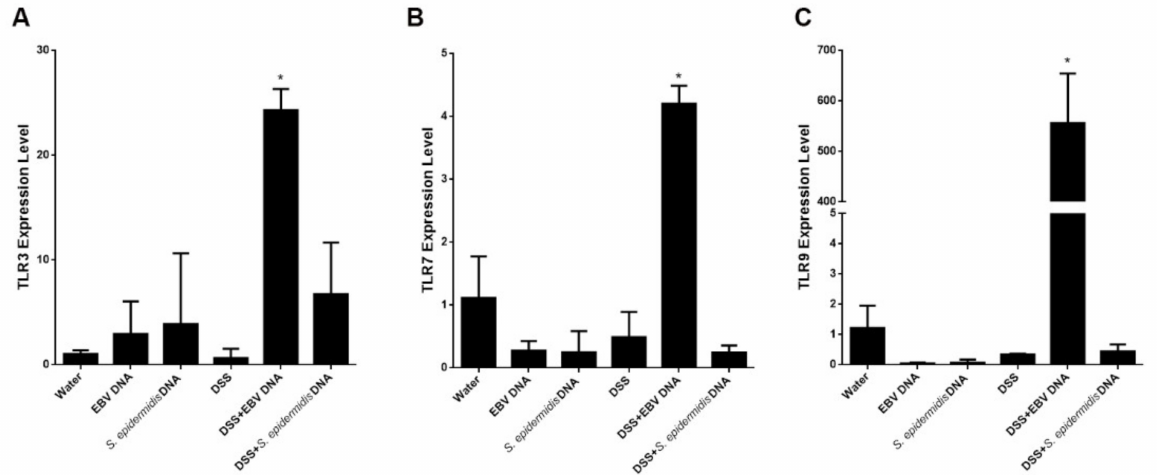
Figure 7. Expression levels of ( A ) TLR3, ( B ) TLR7 and ( C ) TLR9 in control and experimental mouse groups used to assess the effect of Epstein–Barr virus (EBV) DNA on colitis severity in C57BL/6J mice. C57BL/6J mice ( n = 9–14 per group) received either 1.5% dextran sodium sulfate (DSS)-containing or regular drinking water for 7 days. Three DSS-treated groups were then rectally administered sterile water, Epstein–Barr virus DNA in sterile water or S. epidermidis DNA in sterile water on day 3. The other normal drinking water-fed groups were included as controls and also received sterile water, EBV DNA or S. epidermidis DNA by rectal gavage on day 3. On day 7 of the experimental protocol, mice were sacrificed, colons were collected and expression levels were determined in colon sections. Average expression levels per group and standard deviations are indicated. * p < 0.05, compared to the water-treated